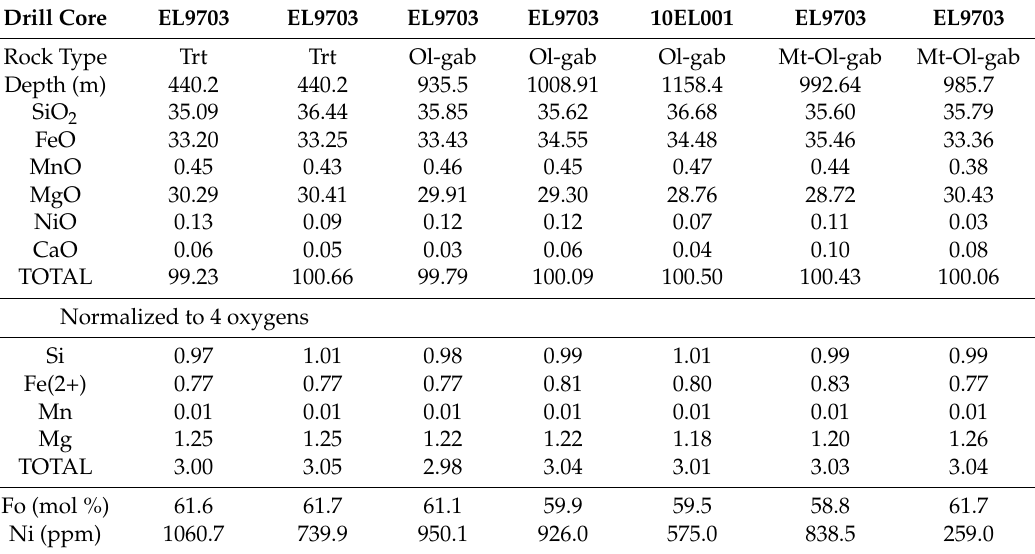
Table 2. Composition of olivine in the major rock